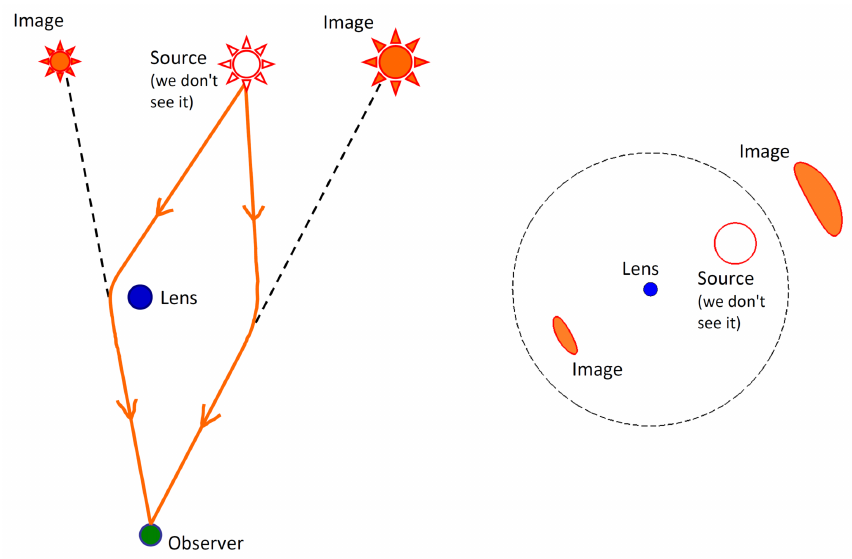
Figure 2. Formation of multiple images of the same source by gravitational lensing in vacuum. The left picture shows a general geometry of the problem and trajectories of the light rays. The right picture demonstrates the positions of images at the observer’s sky. A dashed circle is the Einstein-Chwolson ring.